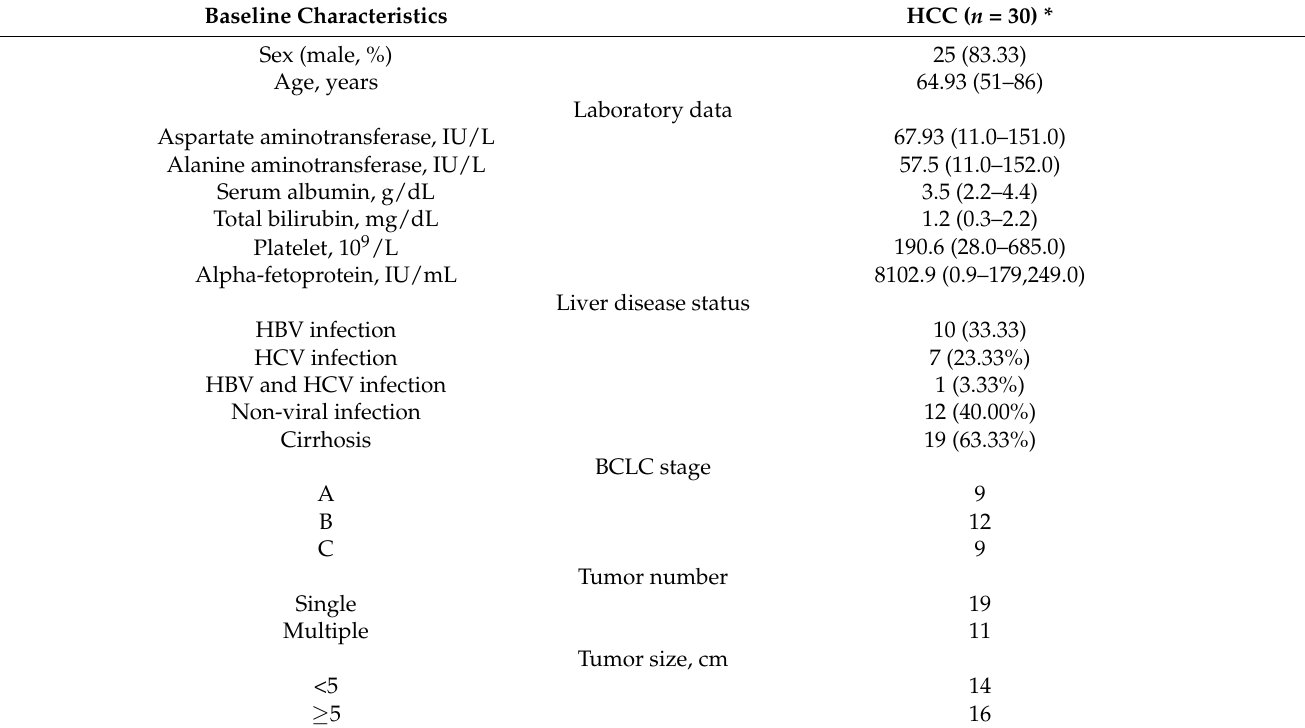
Table 1. Baseline characteristics of cfDNA from 30 patients with HCC for whole-exome